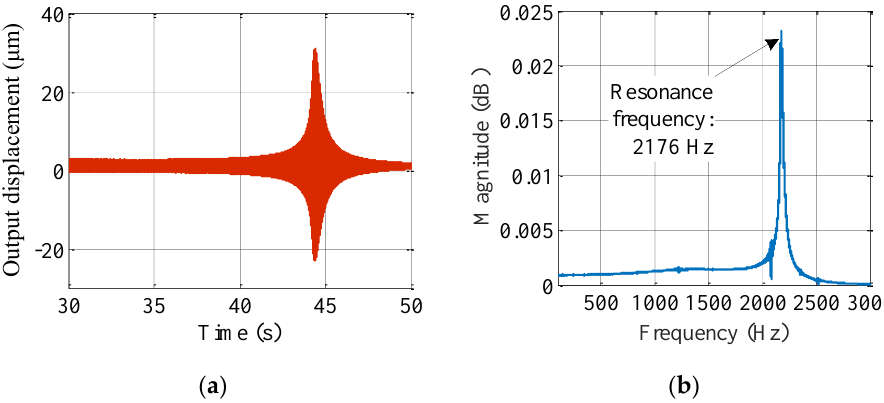
Figure 15. Experimental results of the dynamic response of the presented displacement amplification mechanism. ( a ) Output on the time domain. ( b ) Response on the frequency domain.